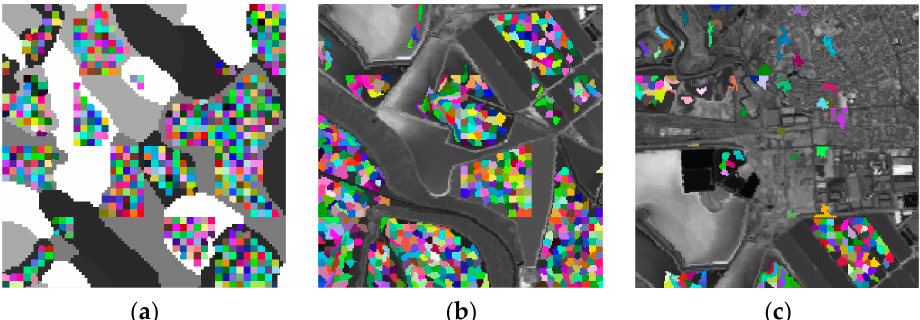
Figure 9. Homogeneous superpixel selection results with the SPHSS on synthetic and real HS images. ( a ) The selected homogeneous superpixels in the synthetic image; ( b ) the selected homogeneous superpixels in the Data Set 1; ( c ) the selected homogeneous superpixels in the Data Set 2. SPHSS, scatter-plot-based homogenous superpixel selection.